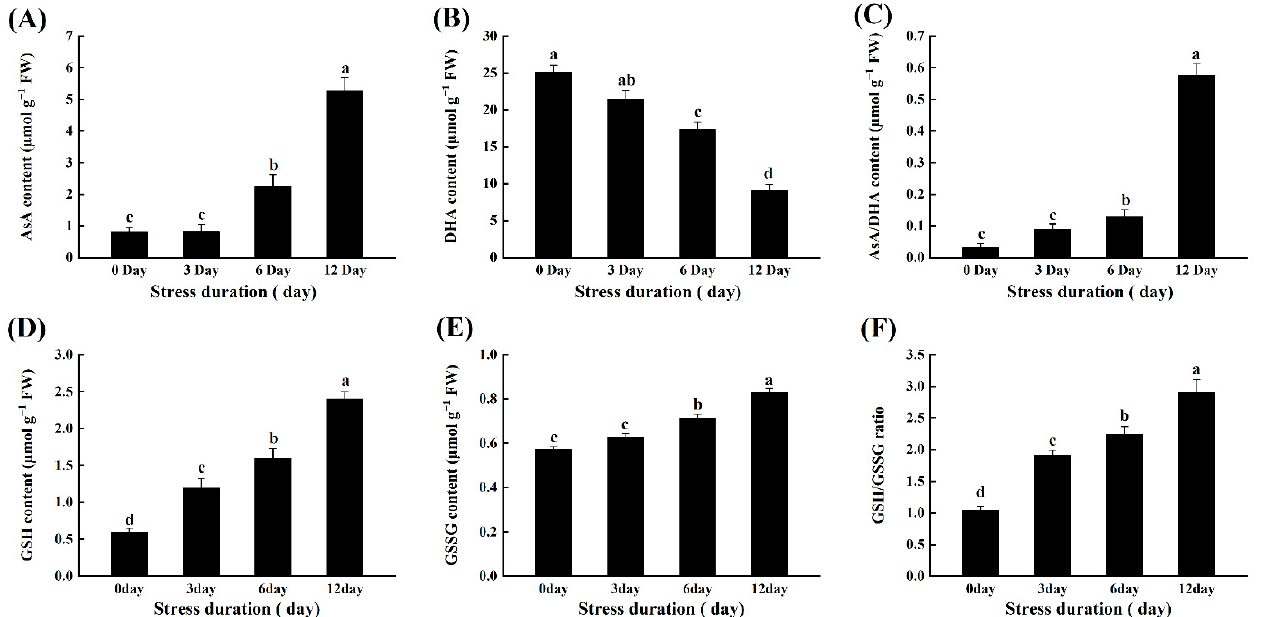
Figure 6. Heatmap of antioxidant enzymes related genes in tomato ( A ) leaves and roots ( B ) after 12 day of salt treatment. The scale (Log 2 of the mean values after normalization; n = 3) shows the increase in relative concentrations from white to red color, compared to control (0 h).